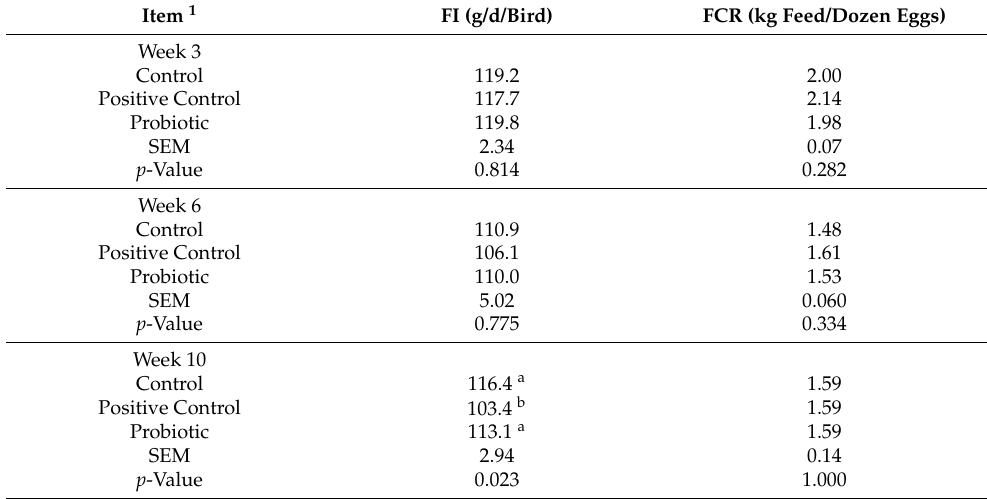
Table 4. Effect of different dietary treatments on feed intake and feed conversion ratio.